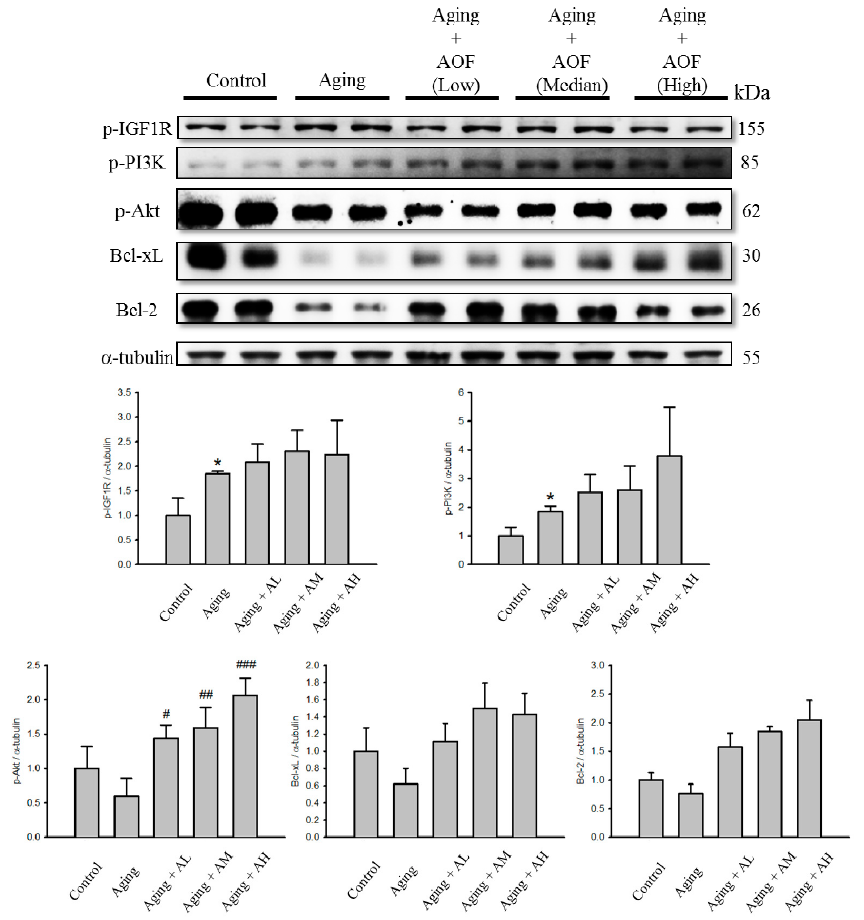
Figure 5. Effect of AOF on D -galactose-induced survival in SD rat cardiac tissue. The total protein of SD rat cardiac tissue extracts was separated by 12% SDS-PAGE, transferred to PVDF membranes, and immunoblotted with antibodies against IGF1R, p-PI3K, AKT, Bcl-xL and Bcl2 antibody to detect survival markers expression. Equal loading was assessed with an anti- α -tubulin antibody. These blots were quantified by densitometry. α -tubulin served as a loading control. Data are presented as means ± S.D. Bars indicate averages, * p < 0.05, represent a significant difference versus the control; # p < 0.05; ## p < 0.01; ### p < 0.001, represent a significant difference versus the aging group. n = three independent experiments for each data point.